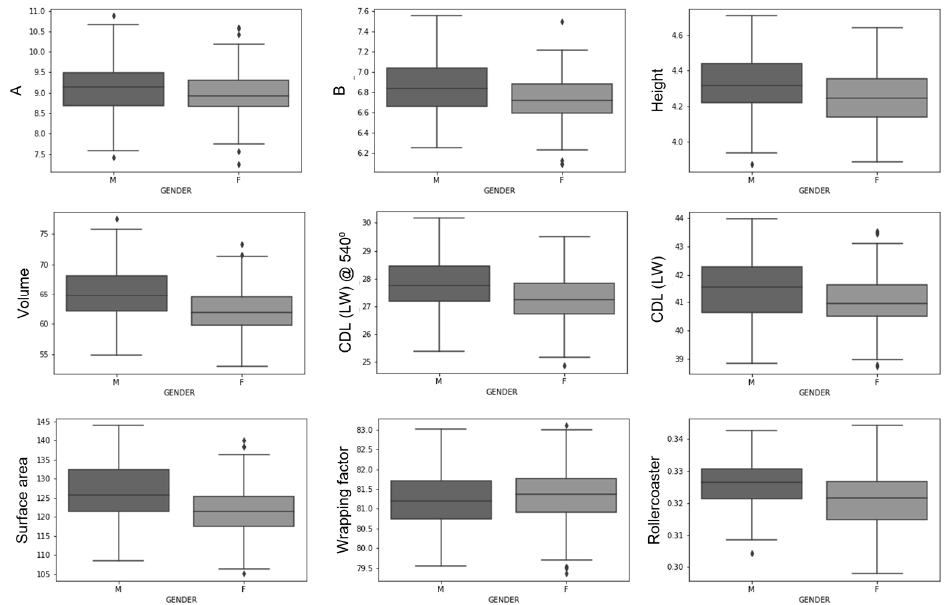
Figure 5. Inter-sex population comparison depicting that female ears are generally smaller and more tightly wound than male ears. CDL (LW): lateral wall cochlear duct length.